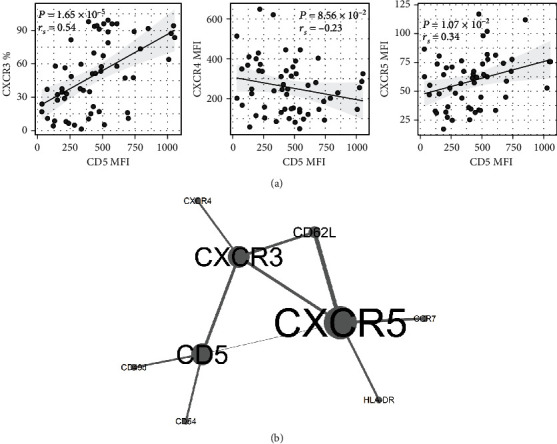
Correlation of CD5 expression with (a) percentages of CXCR3, levels (MFI) of CXCR4 and CXCR5 on CLL cells, and (b) studied chemokines on CLL cells assessed by the correlation network analysis.